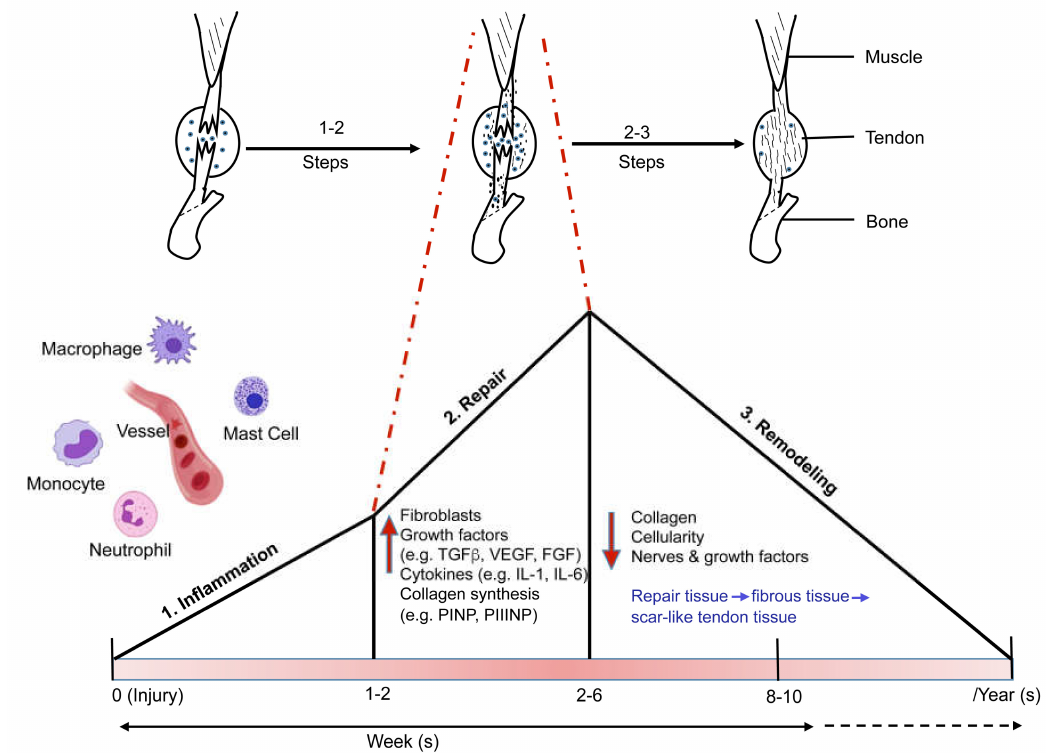
Figure 1. Phases of tendon healing: inflammation, repair, and remodeling. During the inflammatory phase, immune cells (macrophages, neutrophils, and mast cells) predominate. The inflammatory phase is followed by the proliferation or repair phase where fibroblasts produce collagens and extracellular matrix components. The proliferation phase is followed by a remodeling phase, in which the tendon modifies its internal